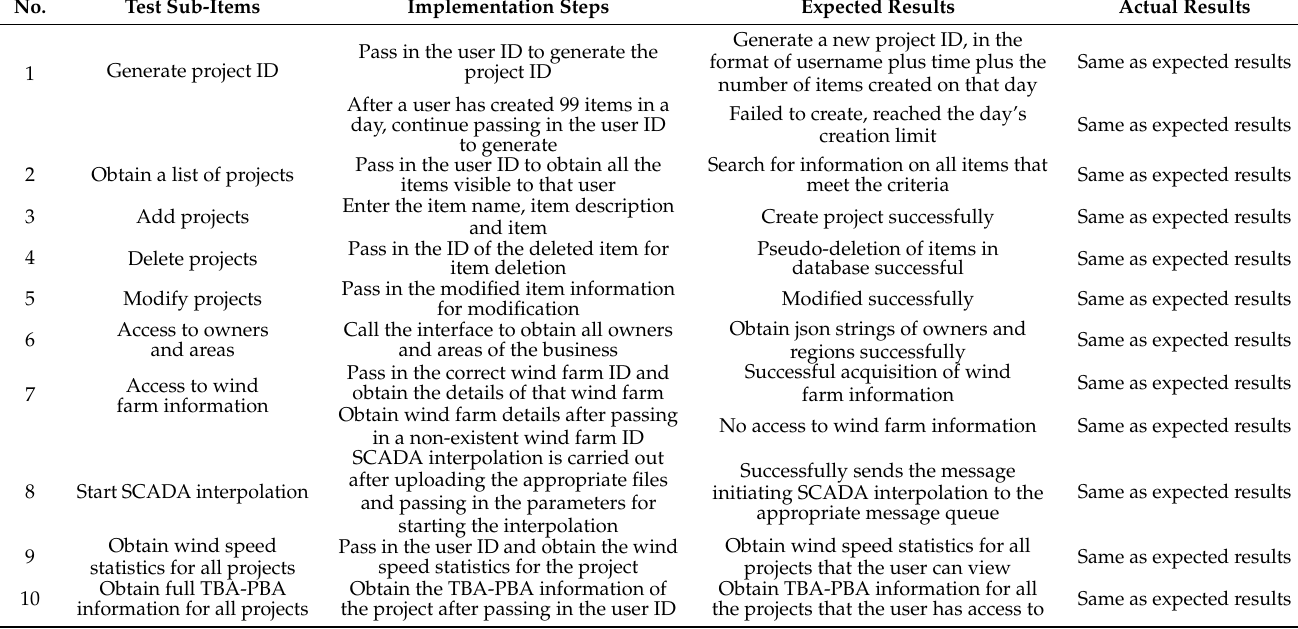
Table 3. Home Page API Test Cases.